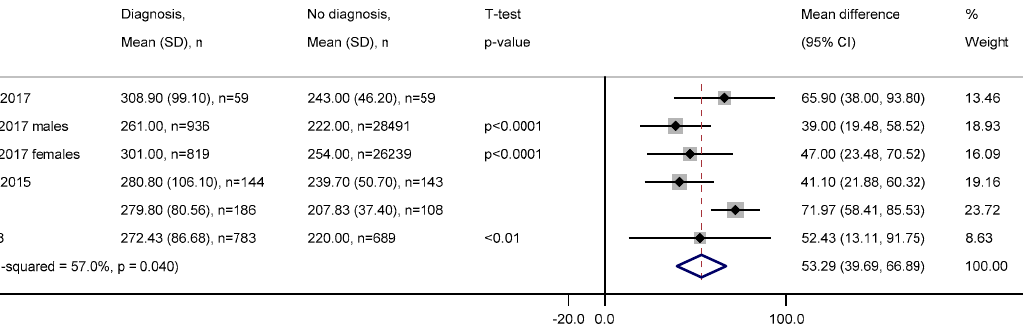
Figure 4. Forest plot of mean difference in platelet count between those with and without a diagnosis of colorectal cancer zero to six months later. Abbreviations: SD = standard deviation, CI = confidence interval. Platelet measurements are in 10 9 /L.